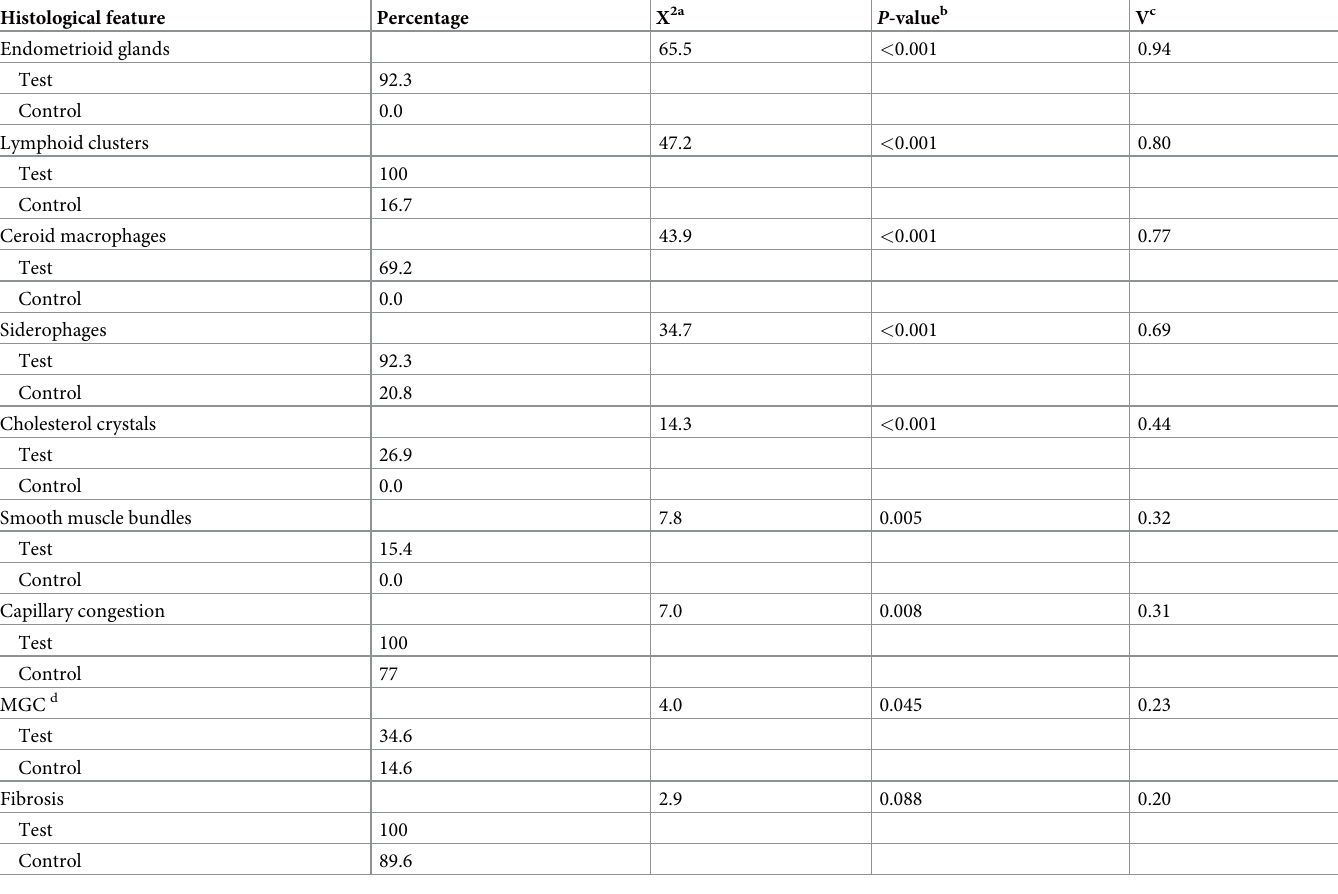
Table 3. Comparison of percentage frequency distribution of histological features in the test and control populations, along with the corresponding Chi-squared test statistic of independence, its P -value and the Crame´r’s V coefficient for strength of